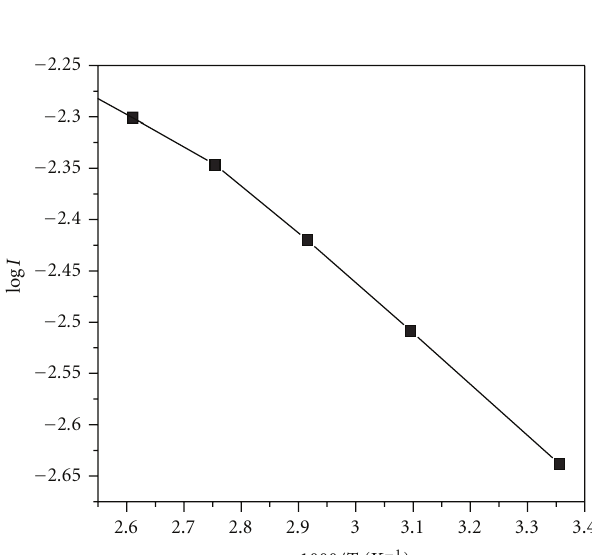
Figure 4: Plot of log ρ versus 1/ T .